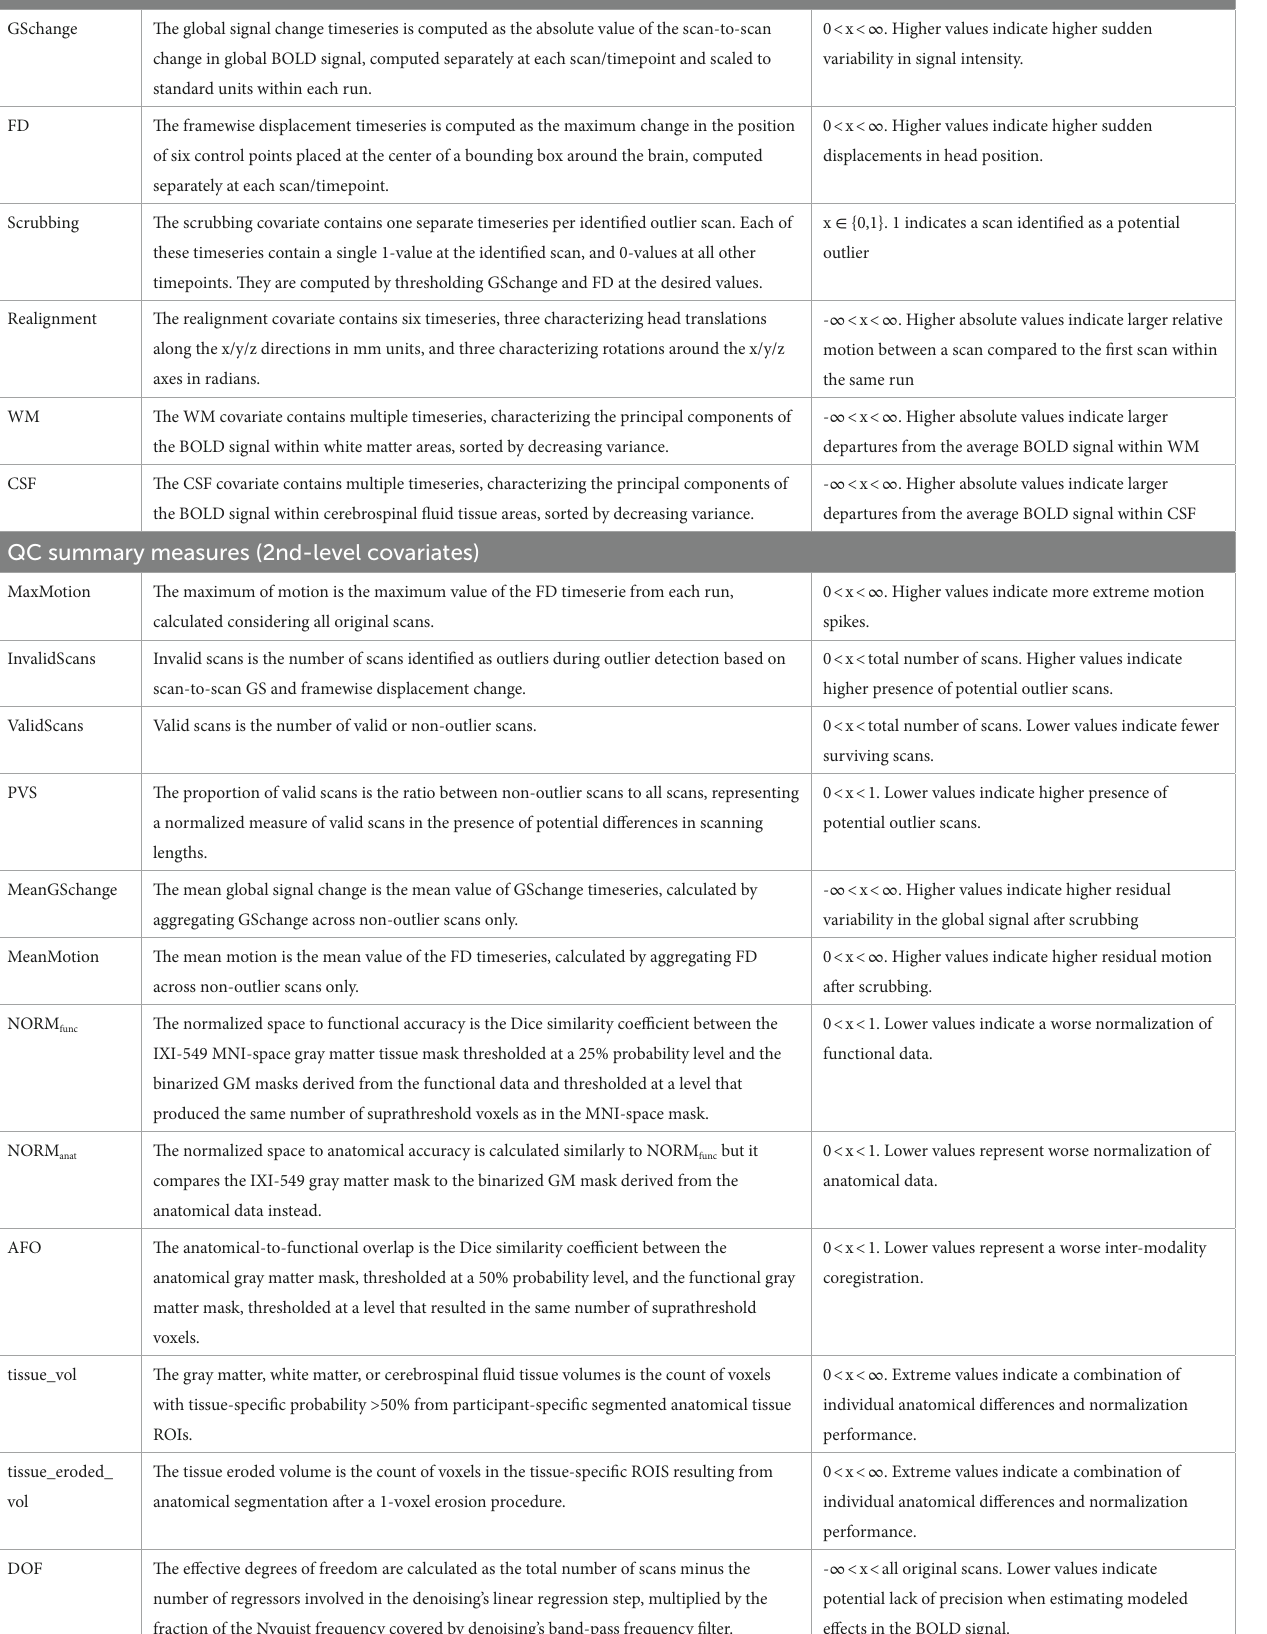
TABLE 1 Summary of automated quality control measures. QC timeseries (1st-level